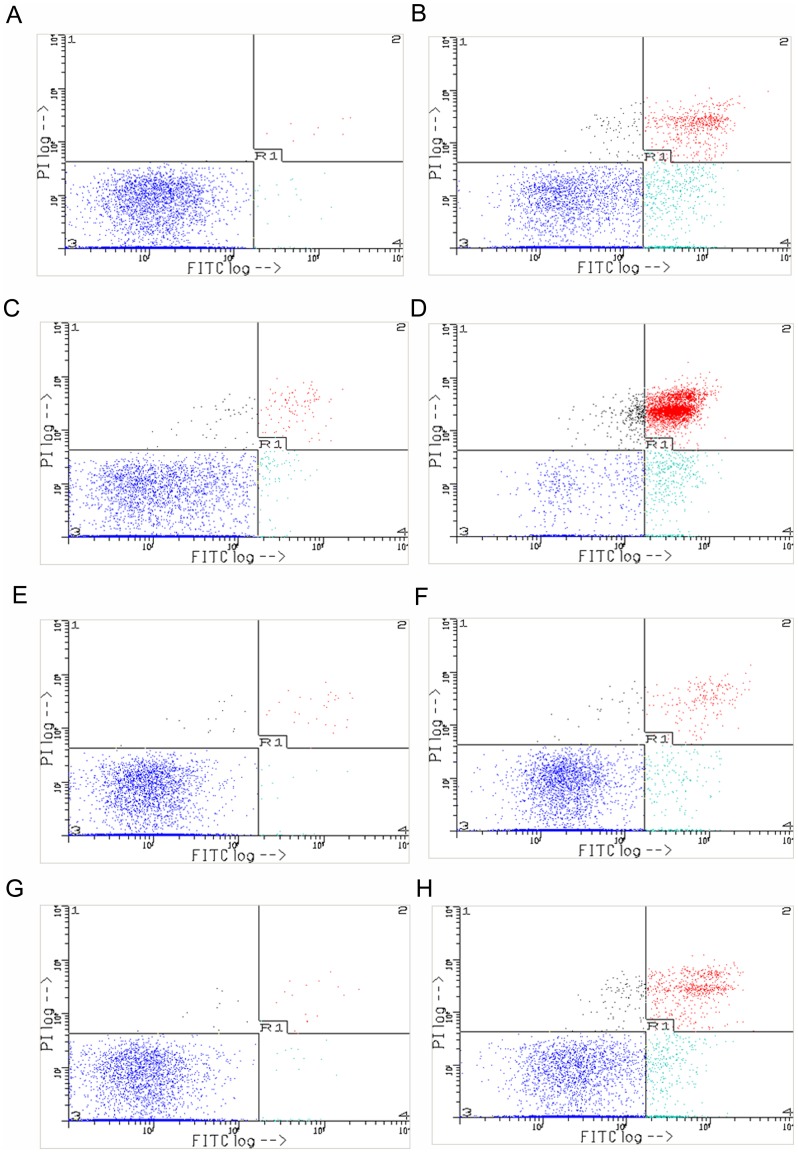
Induction of apoptosis in BEAS-2B cells by ZEA.Early apoptotic cells stained with Annexin V are shown in lower right quadrant. Late apoptotic or necrotic cells are stained with both Annexin V and PI and are shown in upper right quadrant. Living cells are not stained and are shown in lower left quadrant. (A) 24 h wild type control. (B) 24 h wild type ZEA-treated. (C) 48 h wild type control. (D) 48 h wild type ZEA-treated. (E) 24 h CYGB over-expressed control. (F) 24 h CYGB over-expressed ZEA-treated. (G) 48 h CYGB over-expressed control. (H) 48 h CYGB over-expressed ZEA-treated.